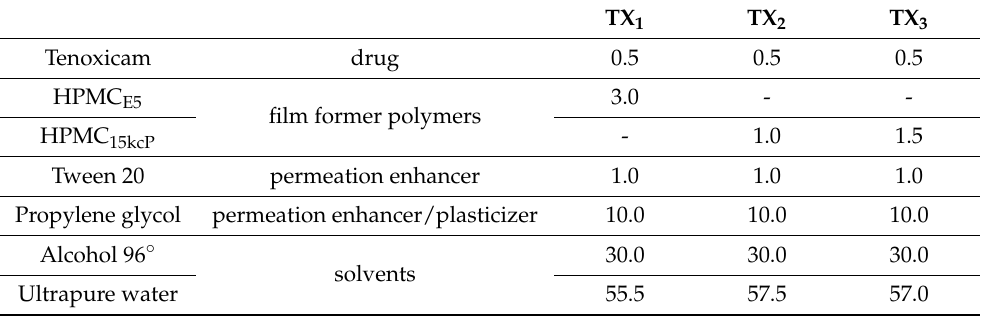
Table 1. Composition of the formulations TX 1 , TX 2 , and TX 3